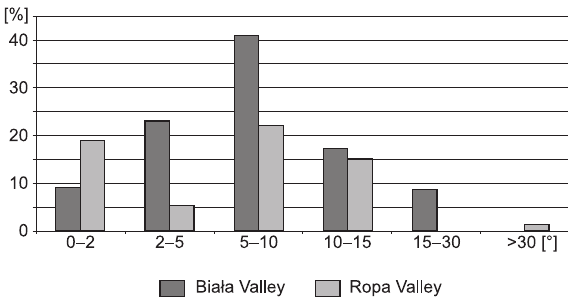
Fig. 3. Slope gradient intervals in the Biała and Ropa valleys (% of the tested